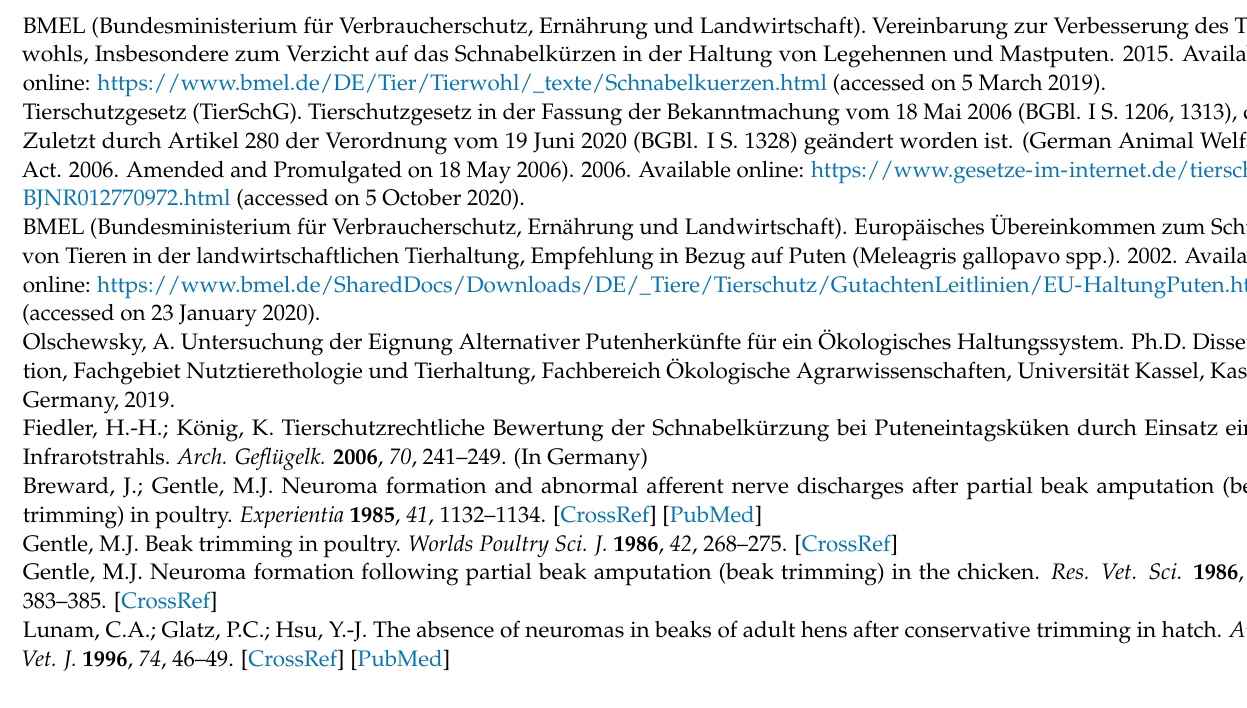
Figure A3. Macroscopic pictures of the head of a dead turkey of our preliminary study, slaughtered after Phase 6 (147 day of life) which was not beak-trimmed and without an integrated screed grinding wheel in the feed pan. On the left side the whole head can be seen and on the right side this head was split lengthwise with a band saw.